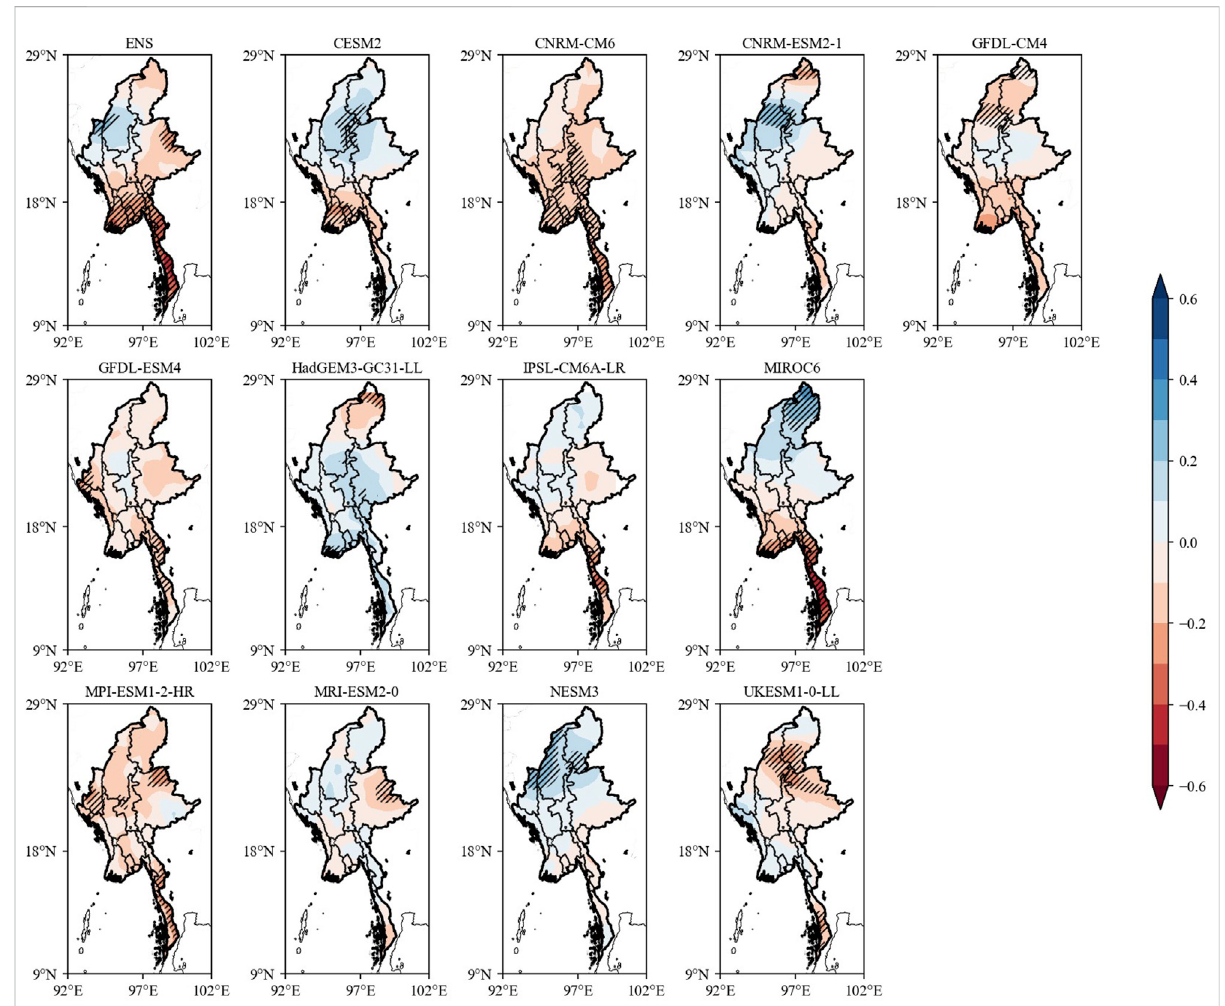
FIGURE 14 MK trend test of seasonal (MJJASO) precipitation for the selected 12 CMIP6 models and ENS. Hatches indicate signi fi cance at the 90% con fi dence